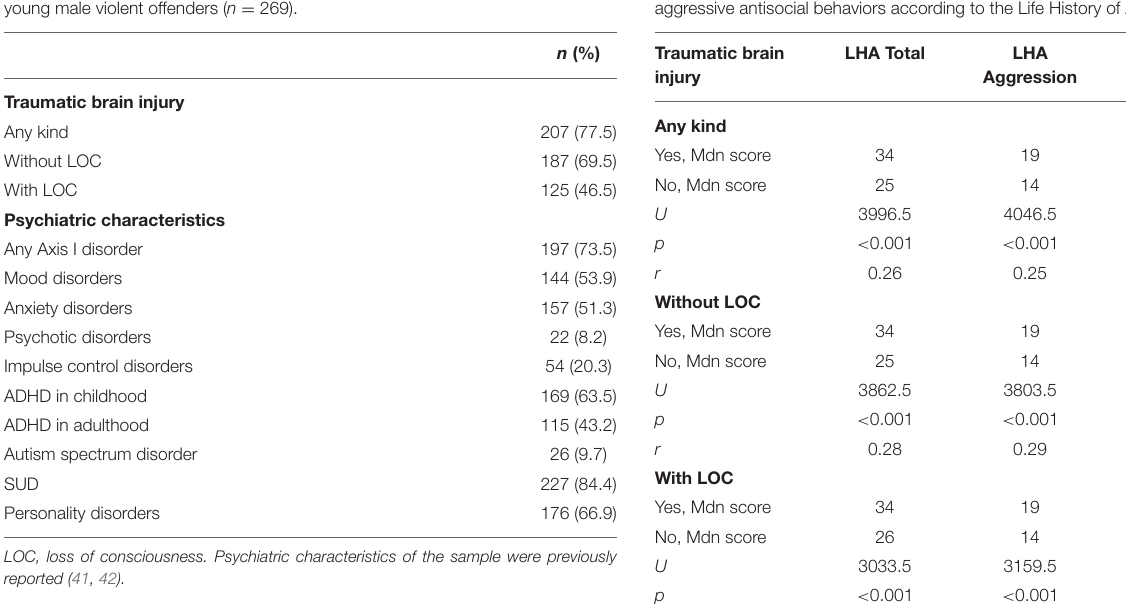
TABLE 2 | Associations (Mann-Whitney U ) between traumatic brain injury and aggressive antisocial behaviors according to the Life History of Aggression.